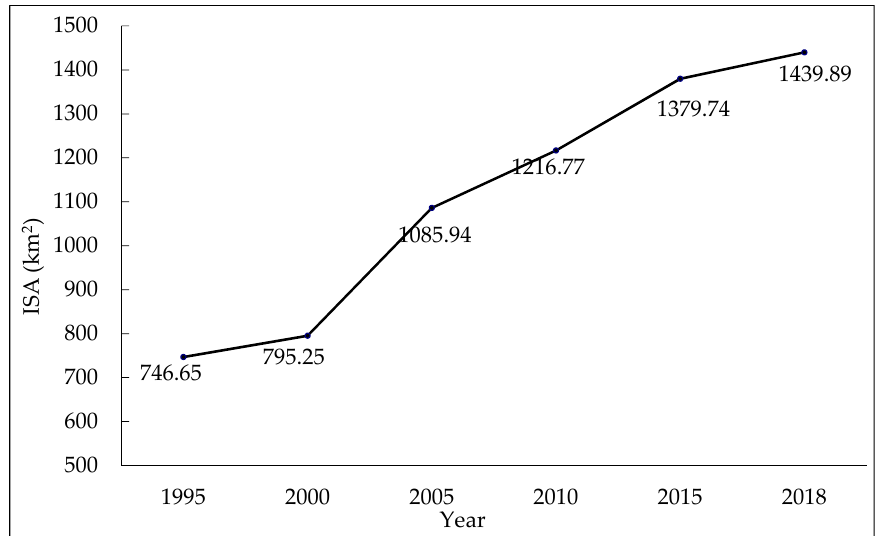
Figure 7. Line chart of ISA change trend in Dongying City from 1995 to 2018. ISA ratio is used to evaluate the expansion speed of ISA in different periods. It is by the time interval. The ISA ratio of Dongying from 1995 to 2018 is shown in Table 3. Table 3. Dongying ISA ratio from 1995 to 2018.